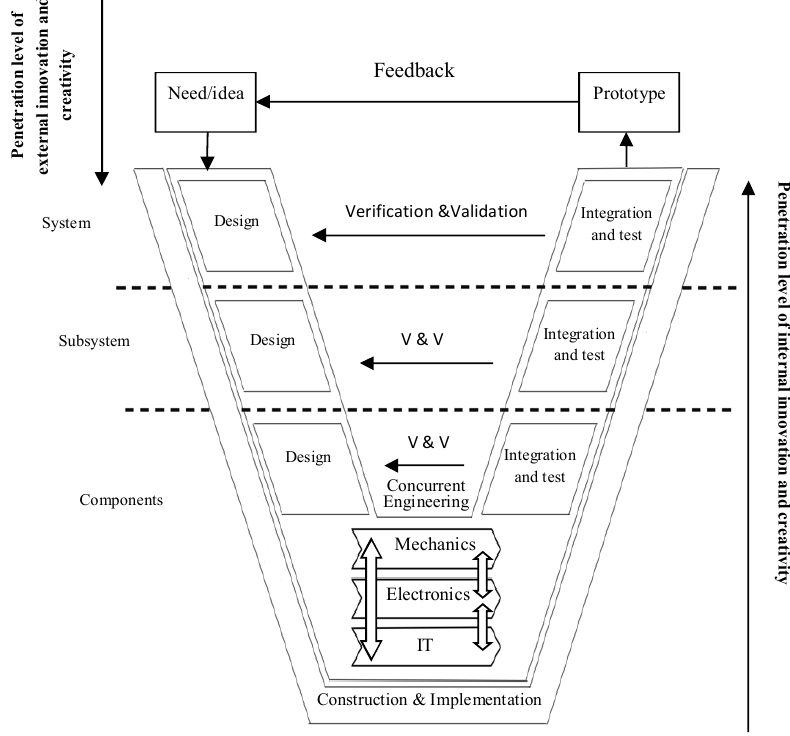
Fig 4. Iterative loop of V-model for design and construction of the prototype (Verein, 2004